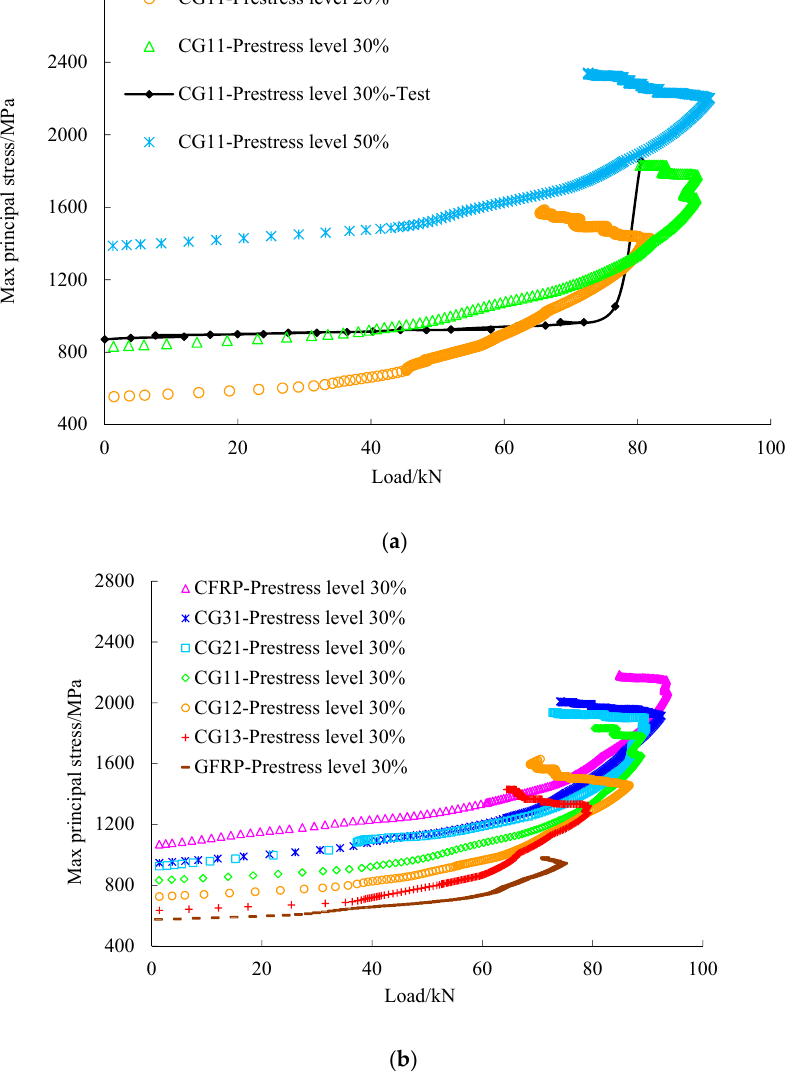
Figure 16. Load-max principal stress of FRP: ( a ) comparison between di ff erent prestress levels; ( b ) comparison between di ff erent hybrid